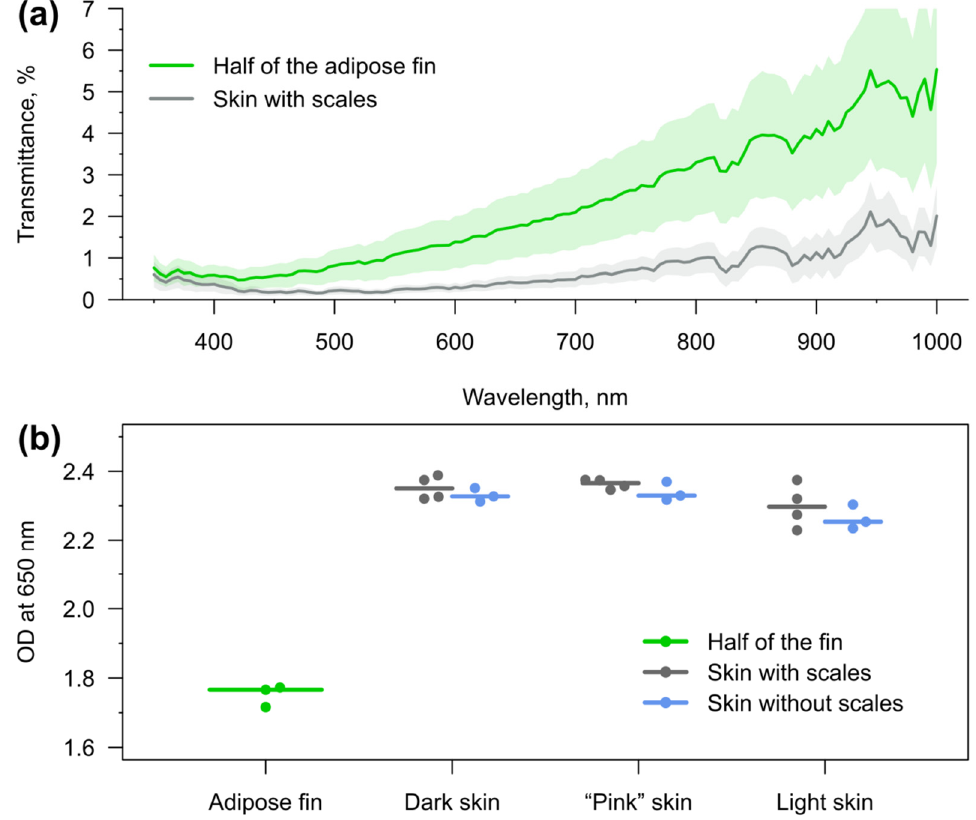
Figure 3. Optical properties of skin and adipose fin of rainbow trout. ( a ) Light transmission through skin and longitudinally cut halves of adipose fin. The spectra are averages over six halves of adipose fin (from three individuals) or 33 skin samples in total from dorsal, lateral, and ventral parts of the fish (from four individuals). The standard deviations are drawn as the ranges. ( b ) Optical density (OD) at 650 nm of the adipose fin and three types of skin with and without scales. Each dot represents individual fish (averaged between two halves of the adipose fin or 2–3 samples for each skin type) and lines show the medians.